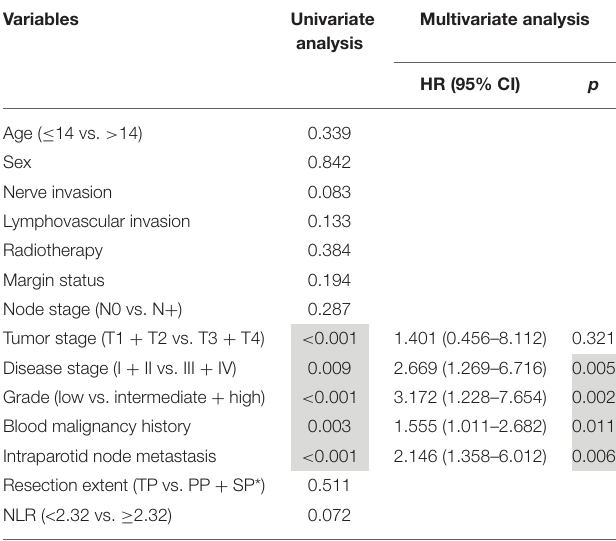
TABLE 3 | Predictors for disease-specific survival in pediatric patients with parotid mucoepidermoid carcinoma.